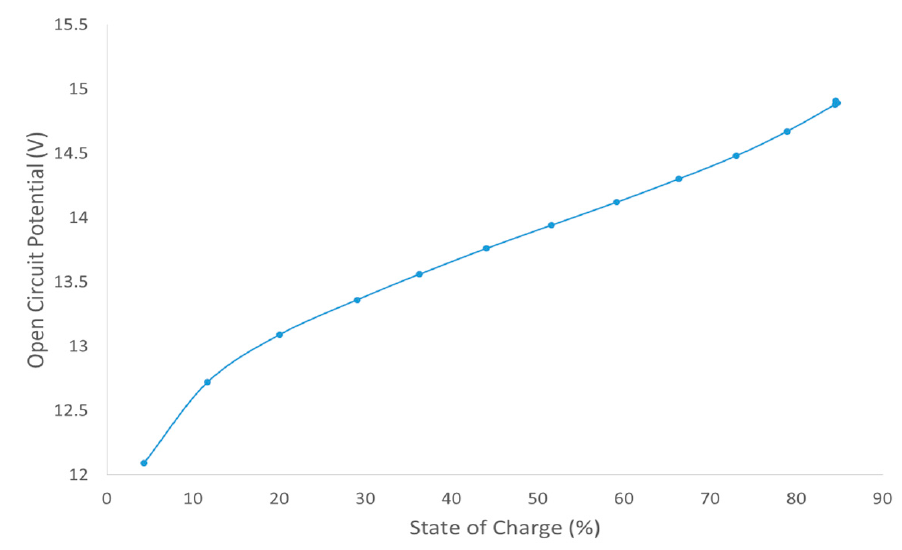
Figure 4. Relationship between the open circuit voltage (OCV) for one stack and the battery state of charge.